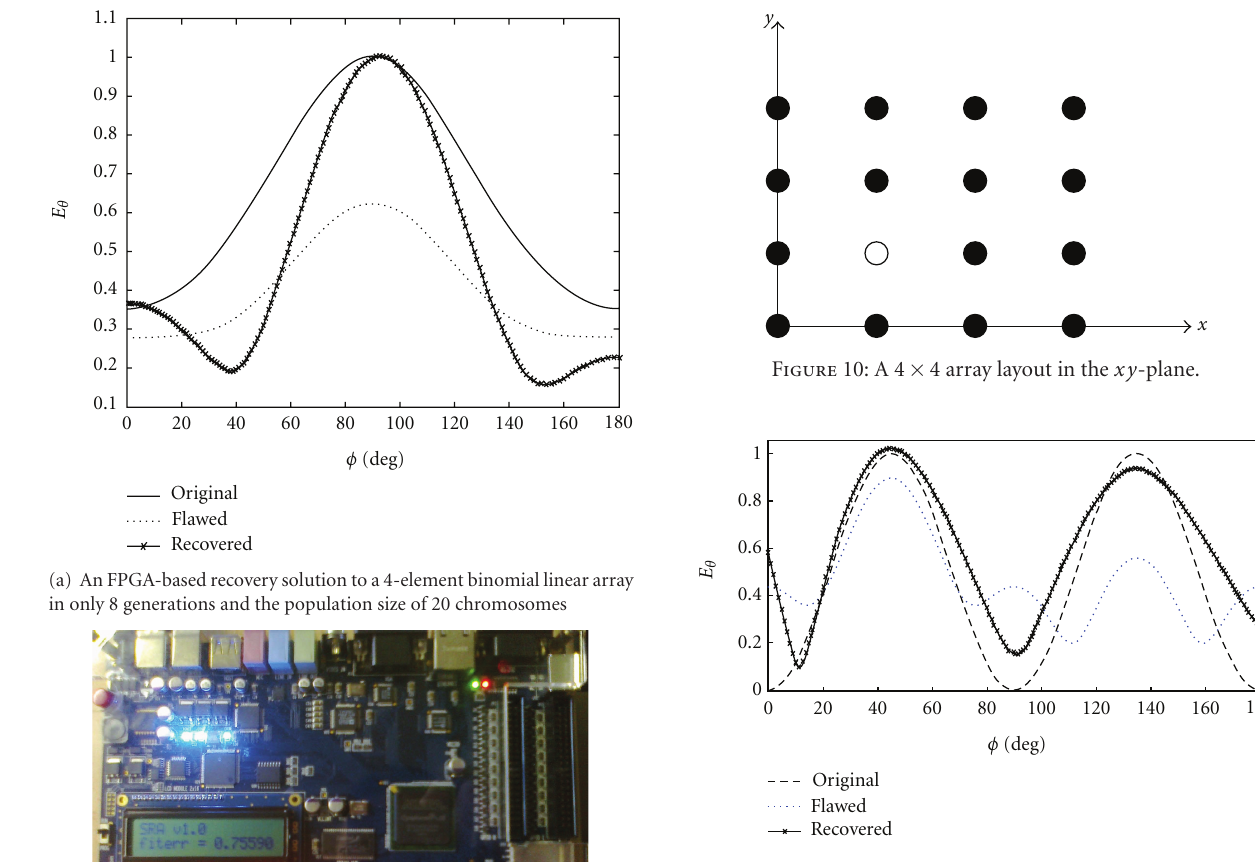
Figure 11: A recovery solution for a 4 × 4 uniform array with element #6 being flawed.